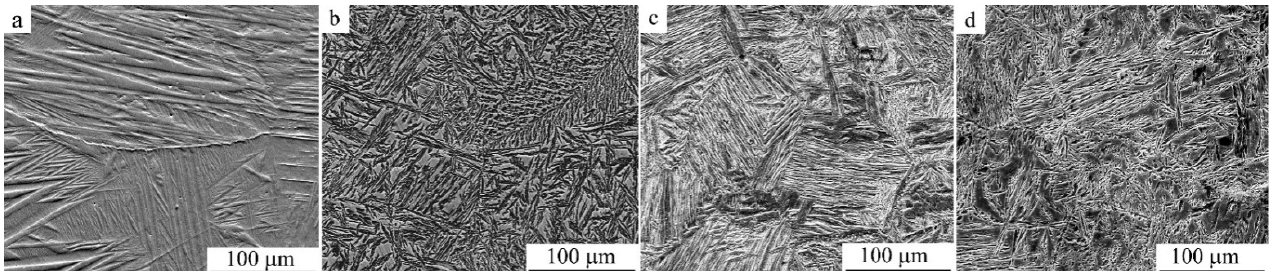
Figure 18. «Stress–strain» (MPa) curves for the Cu–14Al–4Ni alloy under compression tests at a rate of ( a , b , d ) 1 mm/min (continuous line), ( b ) 0.5 mm/min (dashed line), and ( c ) 5 mm/min, at various temperatures (RT, 673, 773, 873, 973, and 1073 K); (insert in ( a )) under subsequent tensile tests at RT alloy quenched at 1223 K [47].